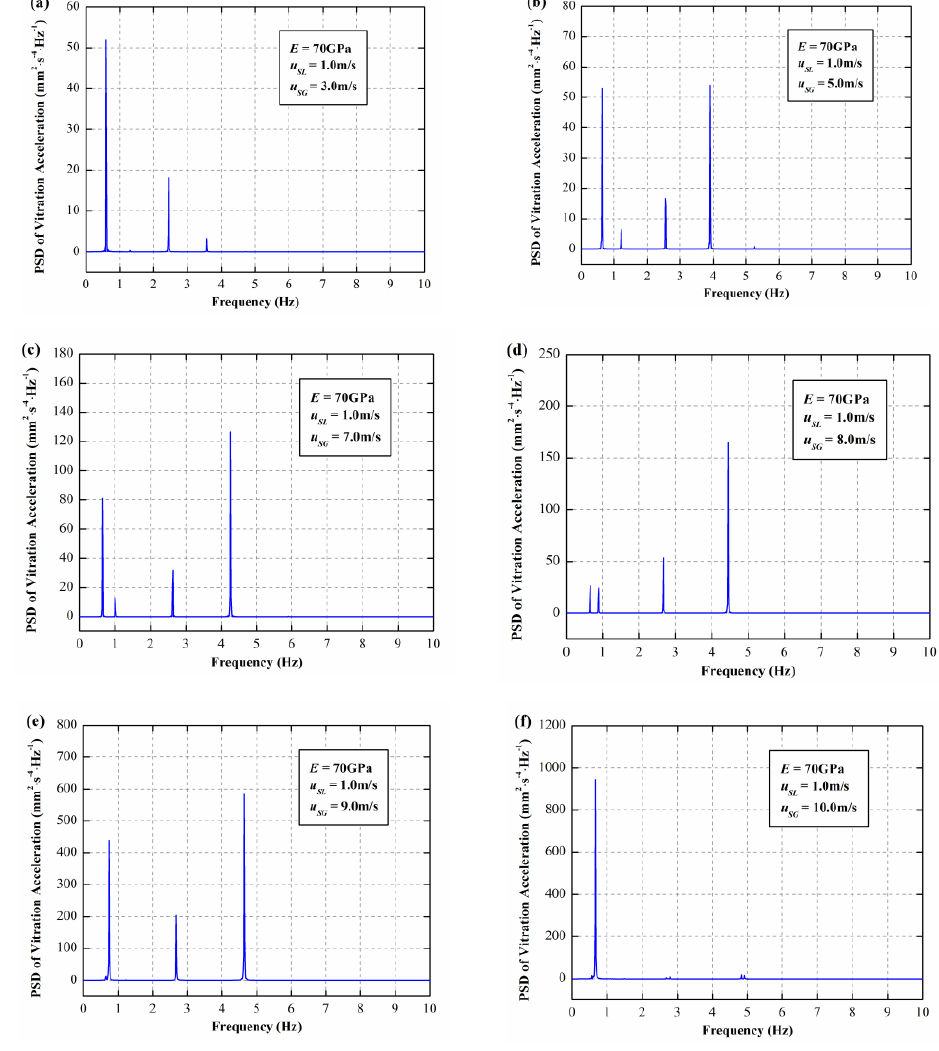
Figure 7. Power spectrum densities of the vibration acceleration for E = 70 GPa and u SL = 1.0 m/s (( a ): u SG = 3.0 m/s; ( b ): u SG = 5.0 m/s; ( c ): u SG = 7.0 m/s; ( d ): u SG = 8.0 m/s; ( e ): u SG = 9.0 m/s; ( f ): u SG = 10.0 m/s).